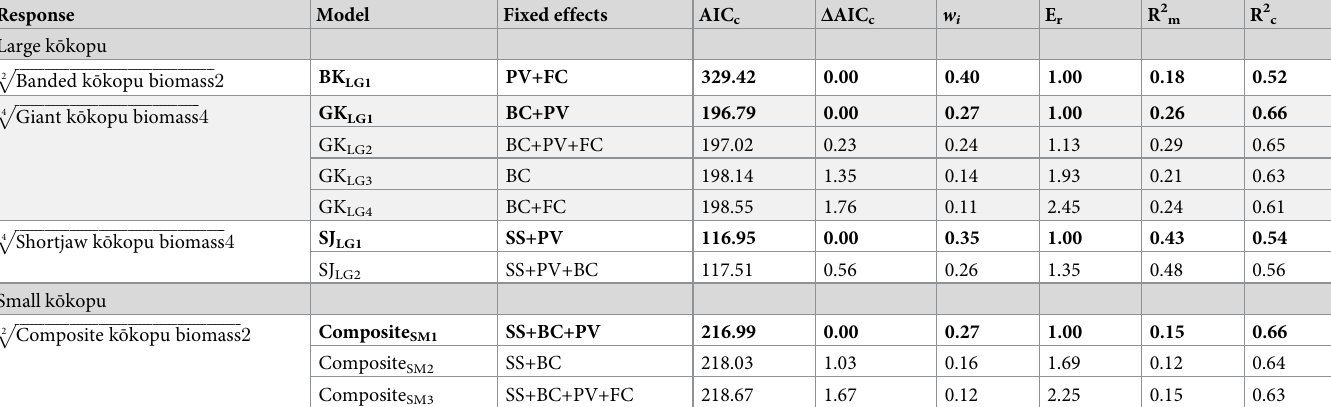
Table 1. Top linear mixed-effects models ( Δ AIC c < 2) that explain variation in the biomass of large and small banded, giant, and shortjaw k ō kopu based on Akaike’s information criterion (AIC).